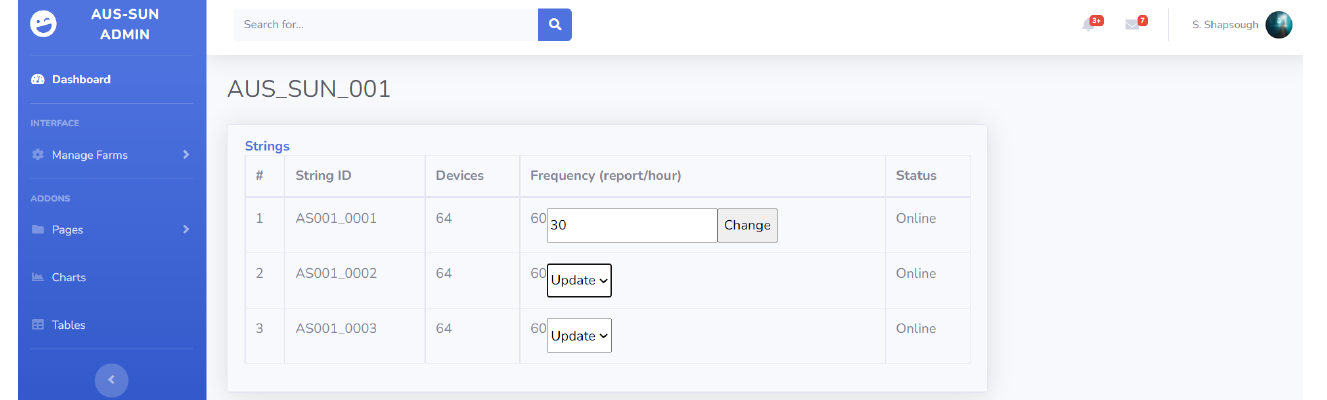
Figure 9. Admin dashboard—device frequency update.